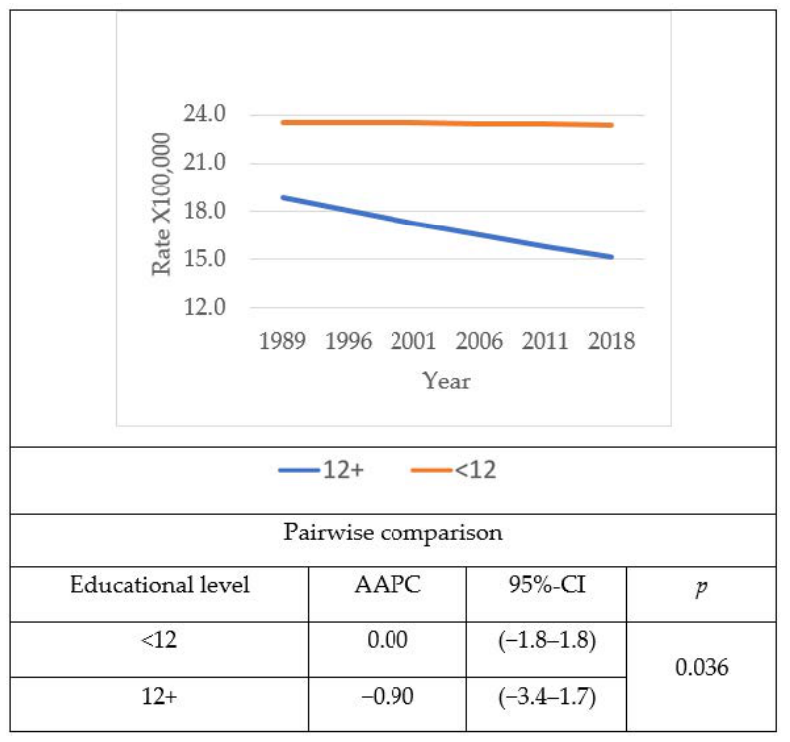
Figure 3. Time trend of age- and sex-adjusted diabetes mortality and average annual percent change (AAPC) among Hispanic females in the US by education level and year from 1989 to 2018. The 2000 USA Census Population was used as standard.